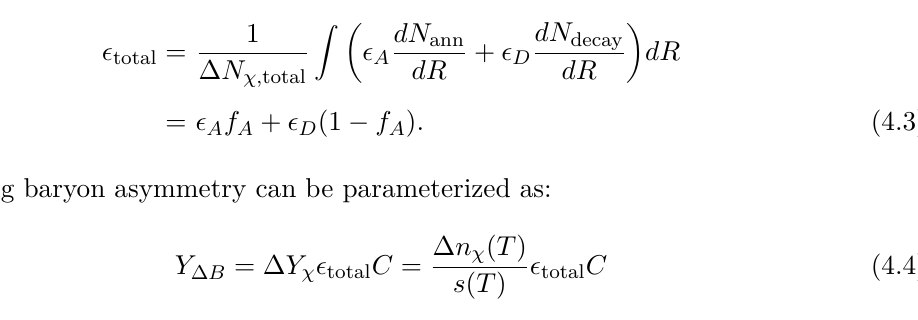
Figure 4 . Contours in the Γ – h σv i plane indicating the fraction of the initial abundance that remains in the unbroken phase when the pocket radius reaches R = 1 /M in combinations of T and R 0 as in figure 3. The black contours correspond to points shown in figure 3 where f A = 1 / 2